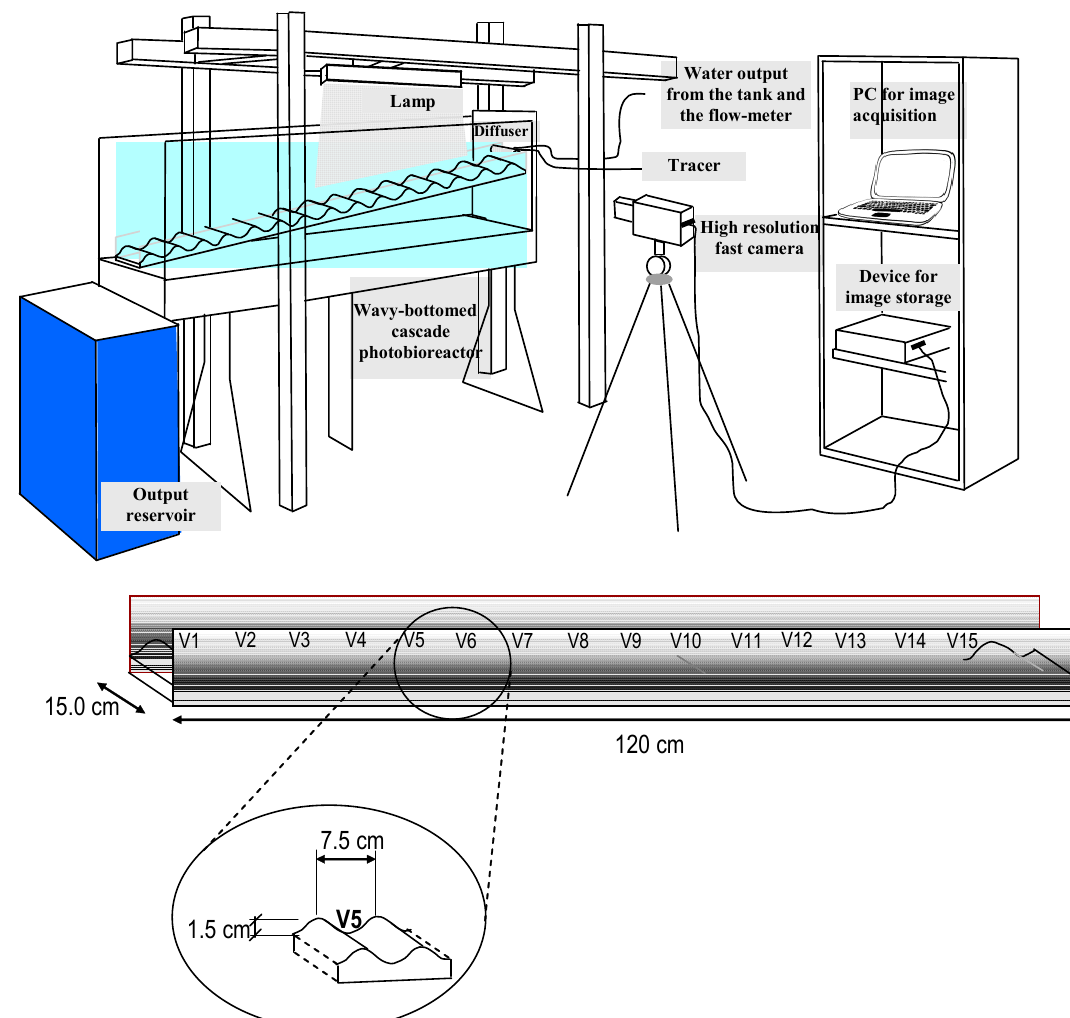
Figure 1. Experimental setup and the channel featuring characteristic dimensions. V stands for vane.